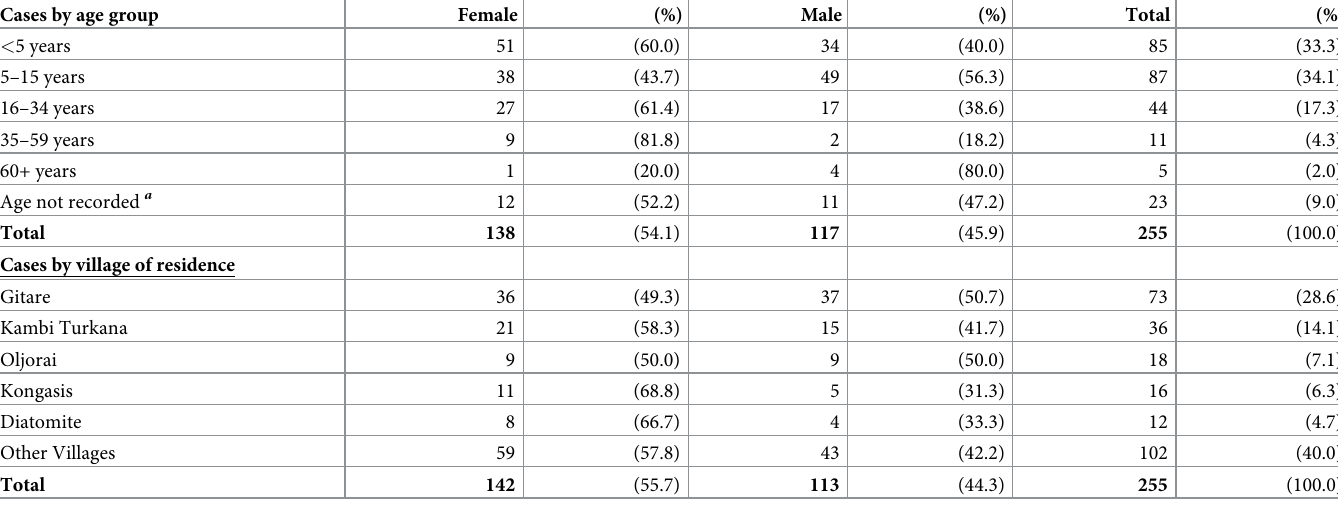
Table 1. Demographic characteristics of suspected cases of cutaneous leishmaniasis based on review of records from nine health facilities in Gilgil, 2010–2016 (n = 255). Cases by age group